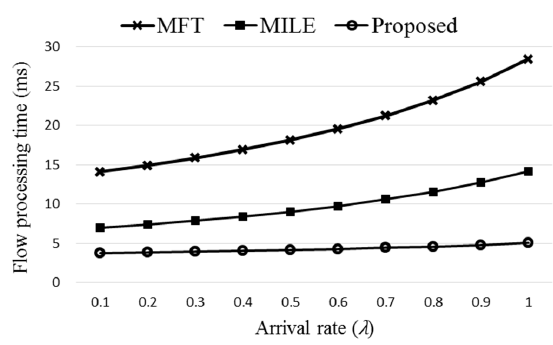
Figure 12. The comparison of flow processing times with varied arrival rate.